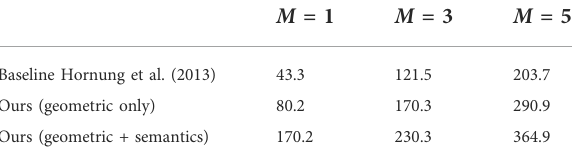
TABLE 6 Average occupancy per iteration step.